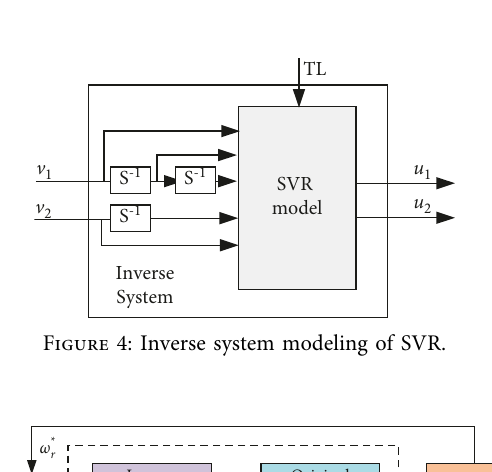
Figure 3: Diagram of pseudolinear system.